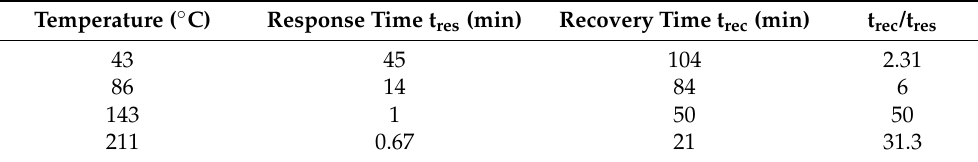
Table 2. Variation of response and recovery times with temperature for sample GO/Fe 2 O 3 6 LbL.